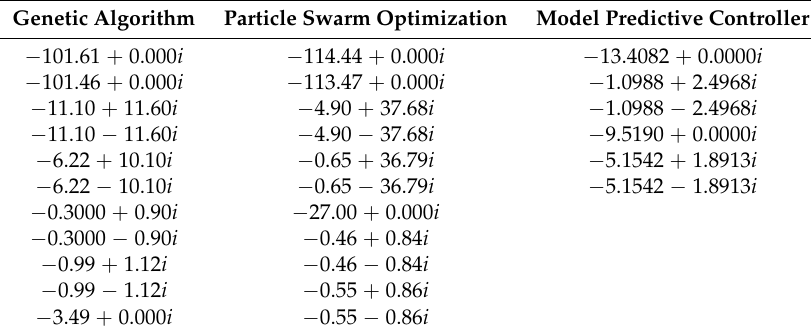
Figure 21. Pole-zero map of PSO-based frequency control loops. Table 6. MPC, PSO and GA based frequency control loops